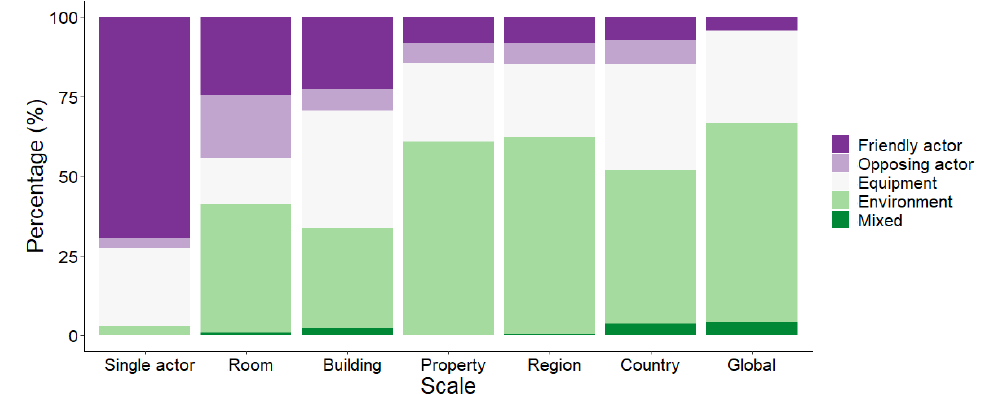
Figure 42. Deployment distribution between scale and subject of the goal